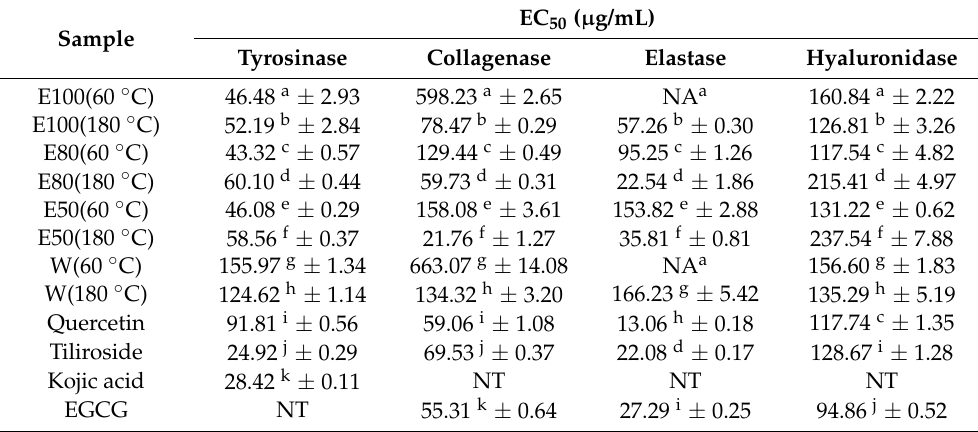
Table 7. Anti-tyrosinase, anti-collagenase, anti-elastase, and anti-hyaluronidase activities expressed as EC 50 of the selected extracts of the herb of A. lanata (L.) Juss., quercetin, tiliroside, kojic acid, and EGCG. Abbreviations: EGCG—epigallocatechin gallate; NT—not tested; NA—no